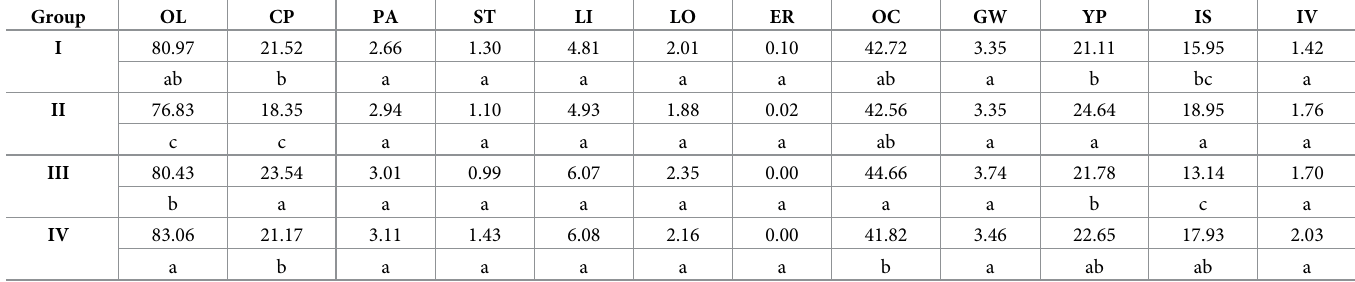
Different lowercase letters in each column indicate significant differences among treatments (p <